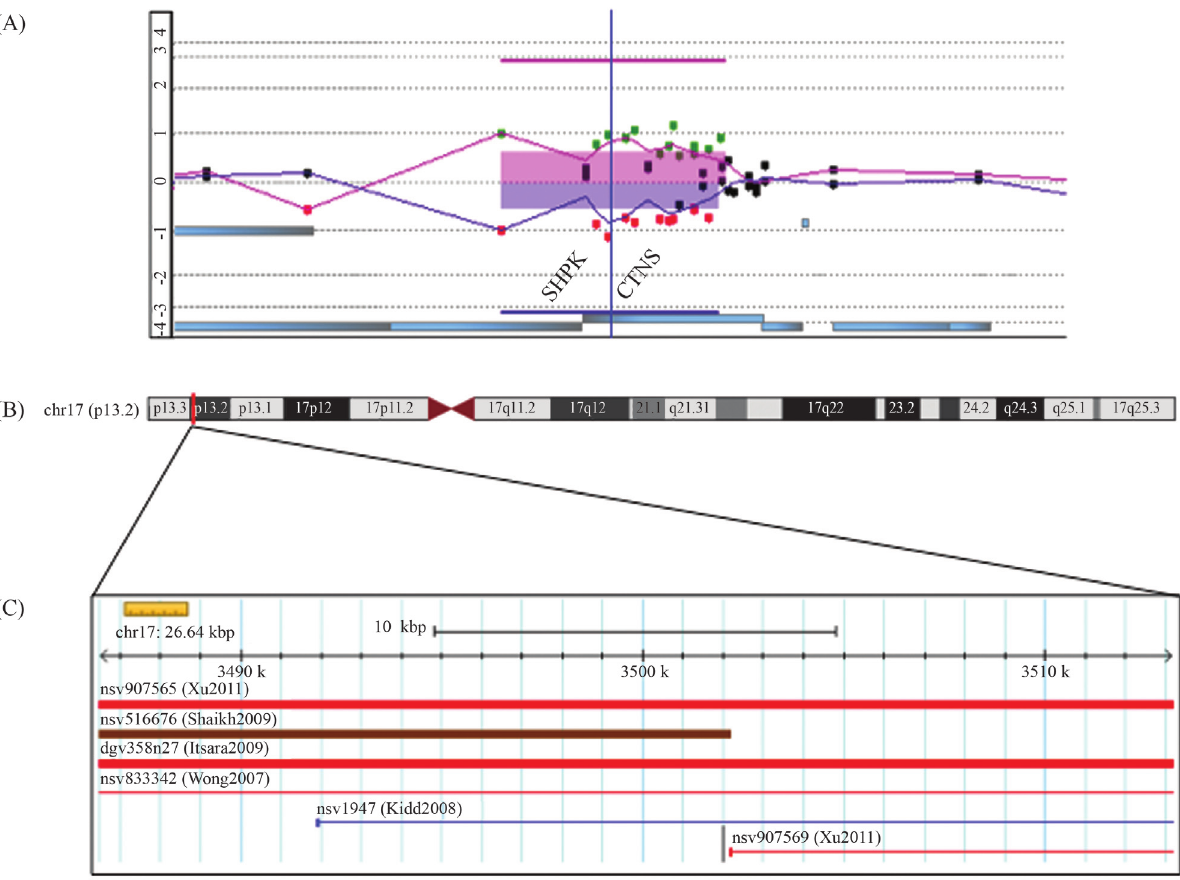
Figure 1 - The 17p13.2 rare CNV detected in a subject with Argyrophilic grain disease. (A) Array-CGH profile of the genomic segment containing the CNV,anditsreverselabelinghybridization(imagebasedontheGenomeWorkbenchsoftware);(B)Ideogramofchromosome17showingthepositionof the CNV (small vertical red bar); (C) Region covered by the CNV. CNV loci reported in the general population are indicated by blue (gain), red (loss) and brown (complex rearrangement) bars in the Database of Genomic Variants (DGV) (image derived from the DGV, freeze September 2013).